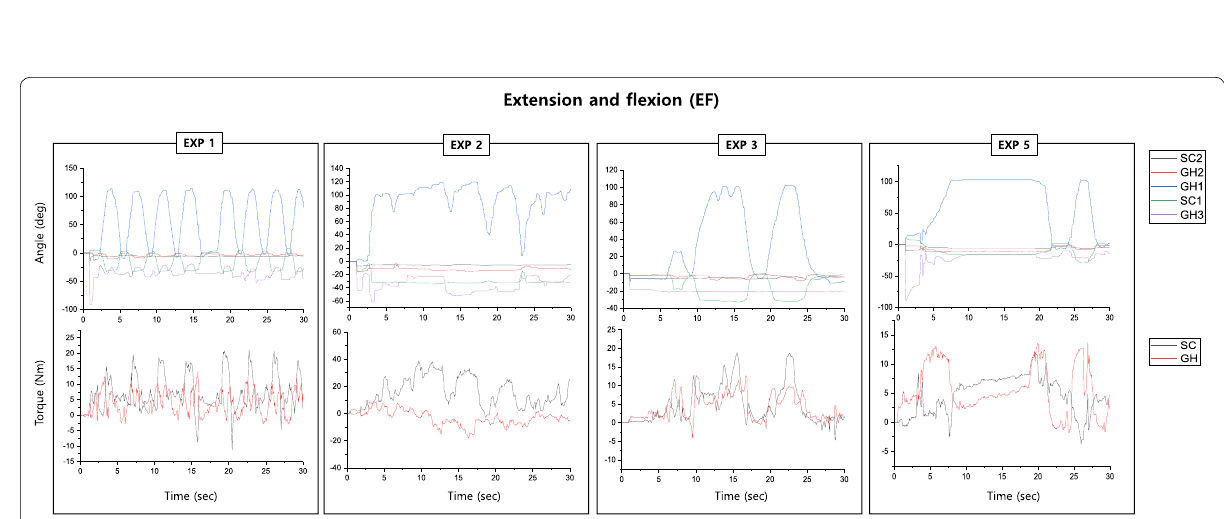
Fig. 6 Experiment values of the raw data of angle and torque in extension and flexion (EF) exercise from experts ( EXP expert, SC sterno‑clavicular joint, GH glenohumeral joint). The x‑axis indicates the time (unit: second). The top and bottom y‑axes represent the angle (unit: degree) and torque (unit: Nm),